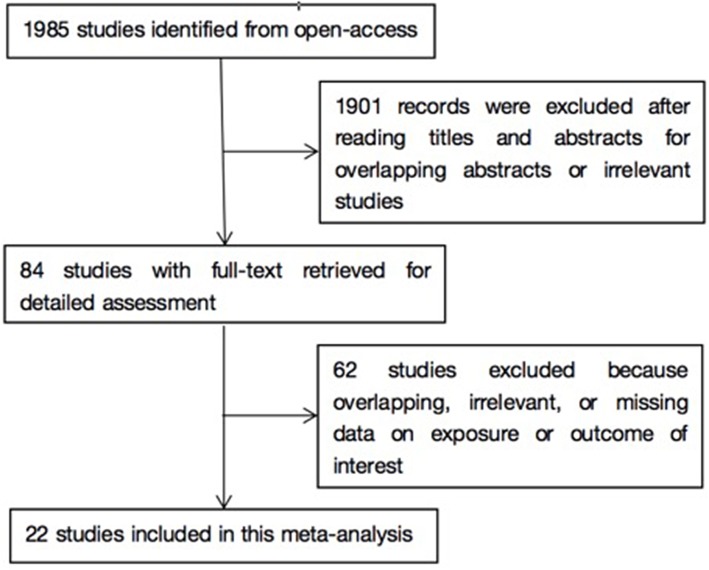
Flow chart of study selection in this meta-analysis.